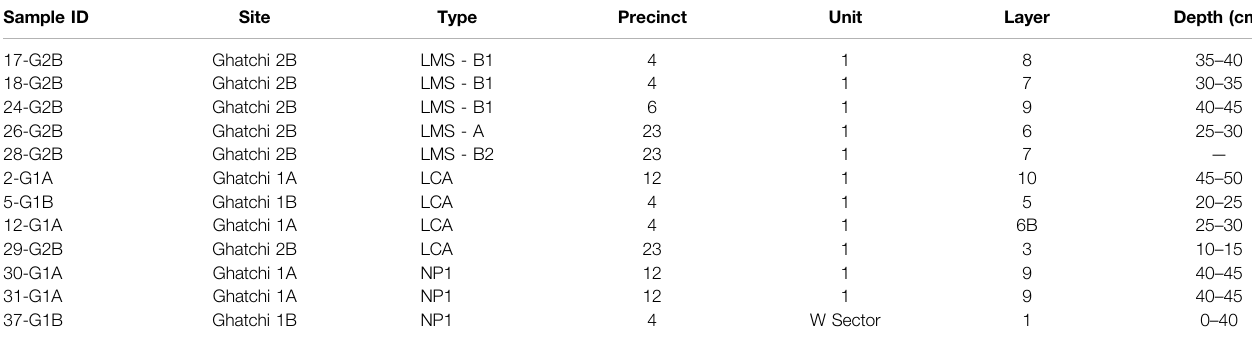
TABLE 1 | Excavation information of the samples collected from the Ghatchi archaeological